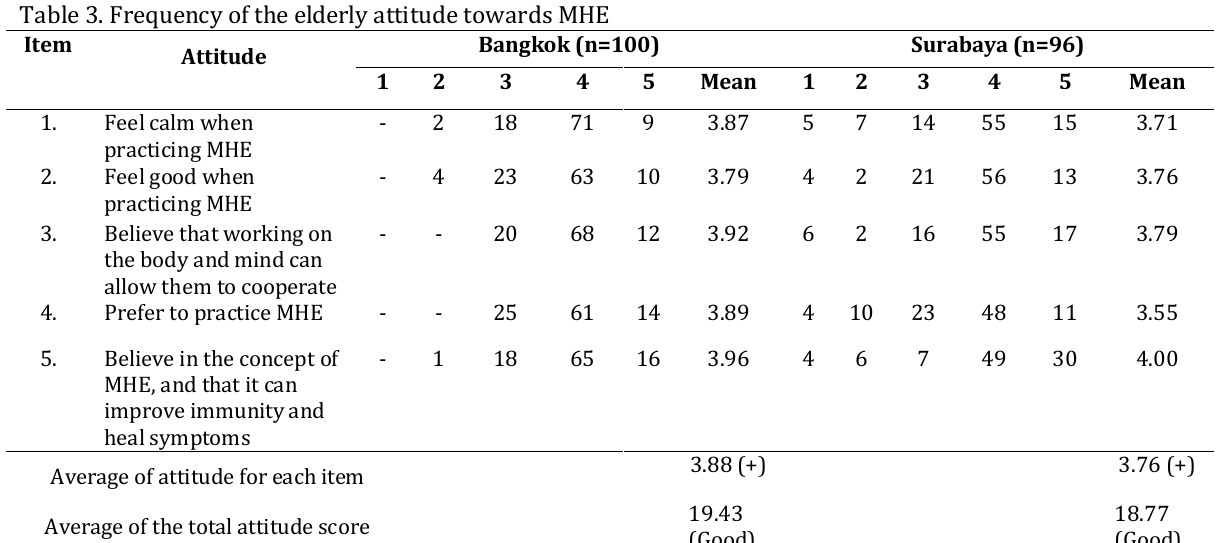
Table 3. Frequency of the elderly attitude towards